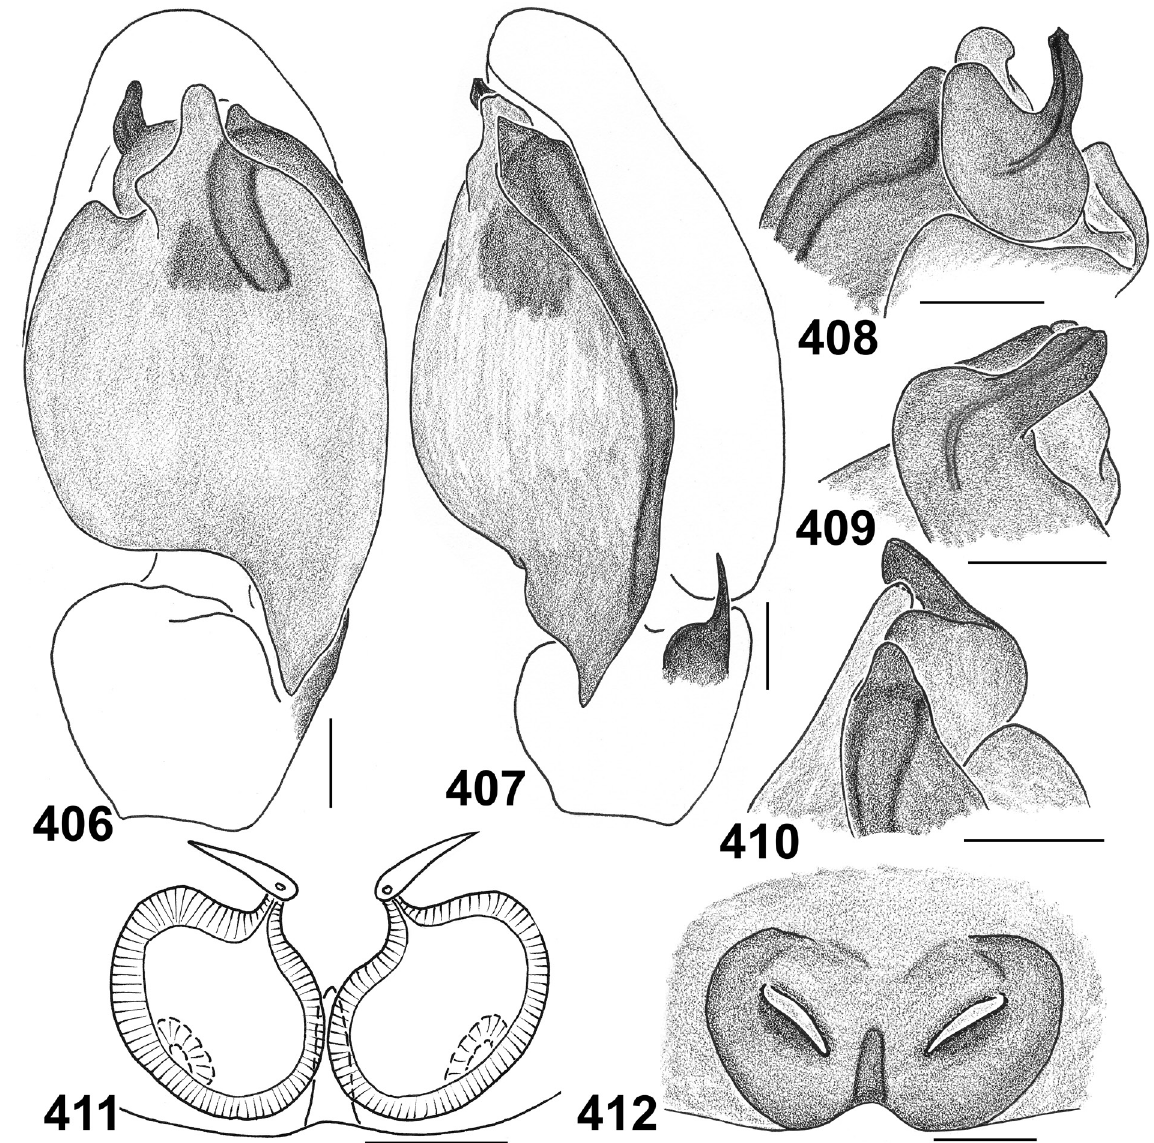
Figs 406–412. Stenaelurillus pilosus Wesołowska & Russell-Smith, 2011, holotype, ♂, and paratype, ♀ . 406 . Male palp, ventral view. 407 . Male palp, retrolateral view. 408–410 . Embolic division. 408 . Dorsal view. 409 . Median view. 410 . Retrolateral view. 411 . Spermathecae, dorsal view. 412 . Epigyne, ventral view. Scale bars: 0.1